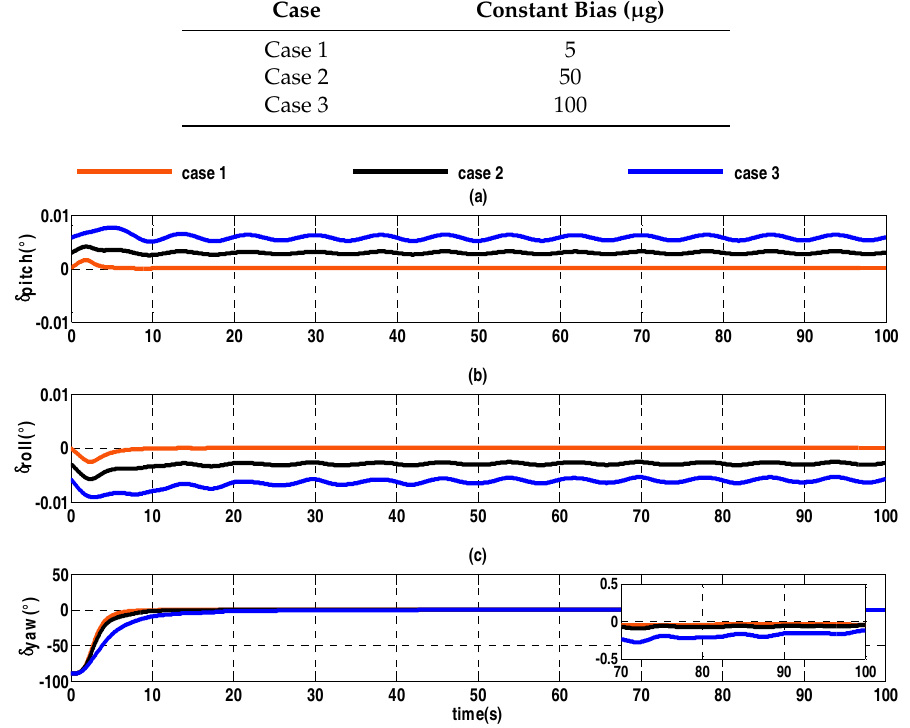
Figure 1. Alignment error curves of three different constant biases. ( a ) The error curves of pitch angle; ( b ) the error curves of roll angle; ( c ) the error curves of heading angle.